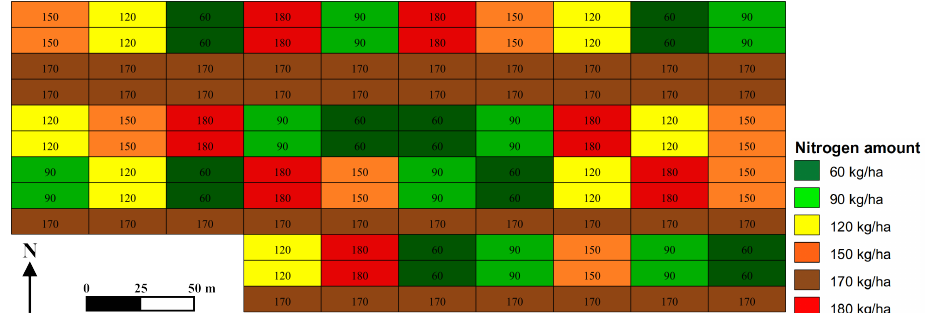
Figure 1. Layout of the experimental field design, here shown for the “Lammwirt” field. The numbers within the plots show the applied nitrogen dosage per year, expressed in kg ha − 1 . The total N amount has been split into three passages over the field. The varieties with 60 to 180 kg N ha − 1 (N1 to N5) have been randomly distributed besides the conventional variety with 170 kg N ha − 1 (K).